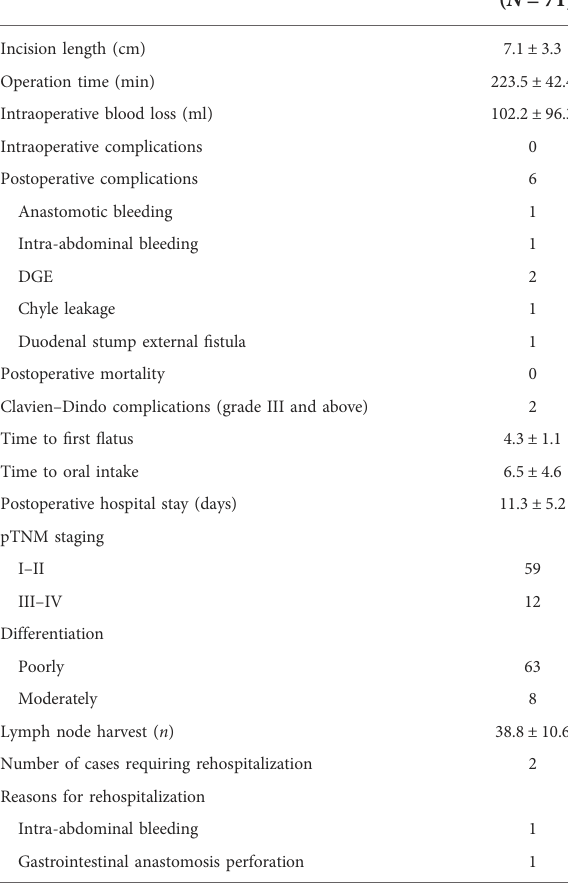
TABLE 2 Operative parameters and short-term postoperative courses.